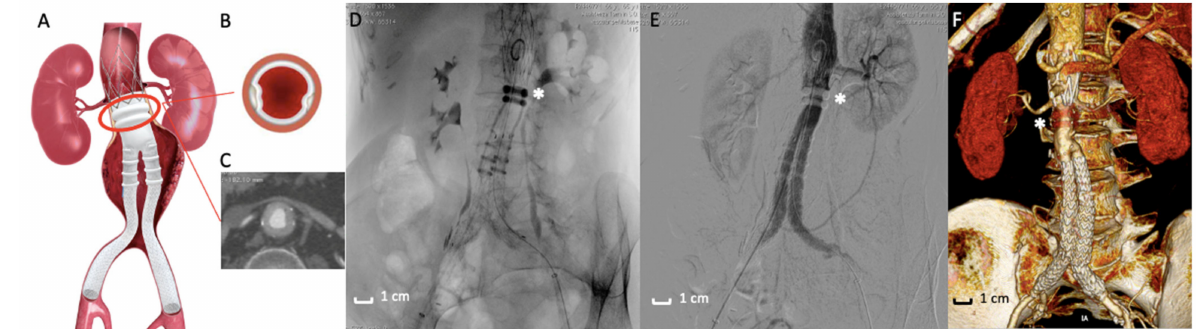
Figure 3. Ovation stent graft. ( A ) Picture of the Ovation endograft. Proximal sealing is assured by polymer filled O-rings (red circle) adapted to the aortic neck anatomy. ( B , C ) Details of the axial appearance of O-rings well-opposed to the aortic wall. ( D ) Intraoperative image of the Ovation stent graft deployed. The asterisk (*) highlights the polymer filled O-rings. ( E ) Angiographic acquisition that reveals the good exclusion of the AAA by the polymer filled O-rings (*). ( F ) 3D volume rendering of Computed Tomography Angiography at 3-months follow-up that shows the correct exclusion of the AAA. The asterisk (*) indicates the polymer filled O-rings located in the proximal fixation